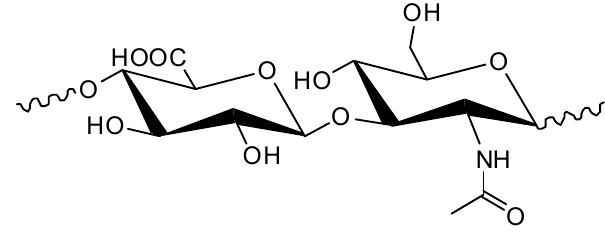
Figure 1. The structure of hyaluronic acid.